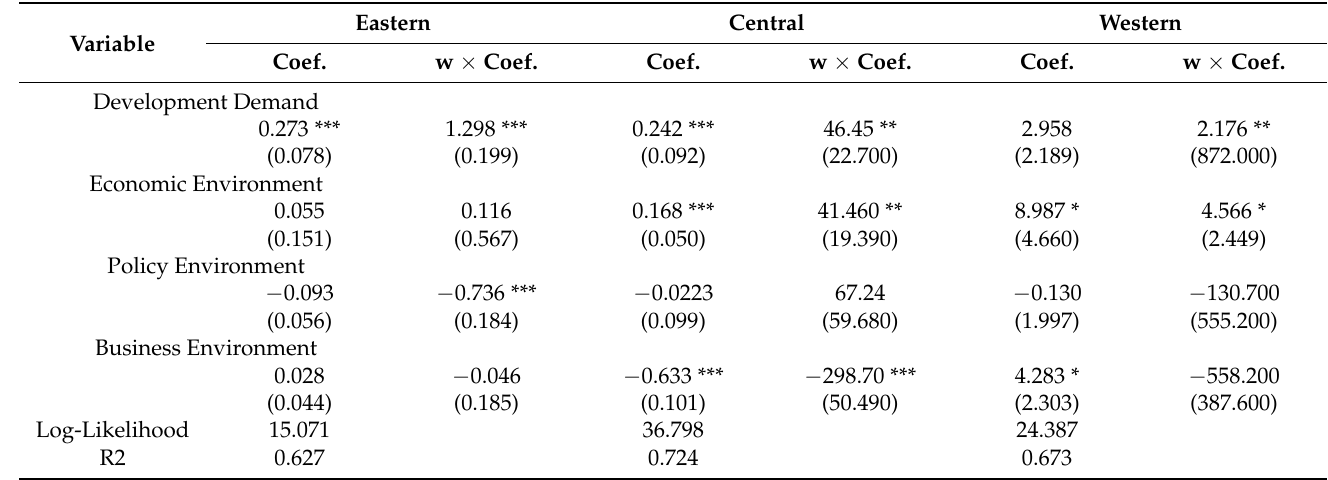
Table 6. Results of spatial panel data models in the eastern, central, and western regions of China (source: authors’ calculations).